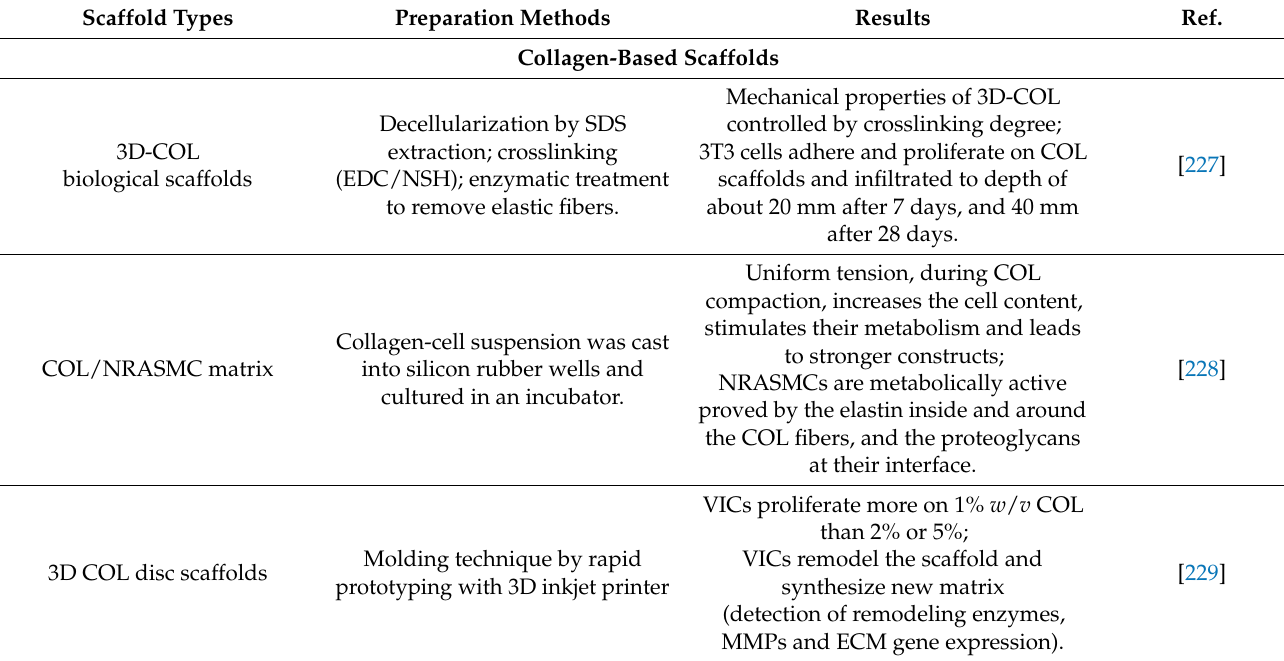
Table 6. Protein-based scaffolds in heart valve tissue